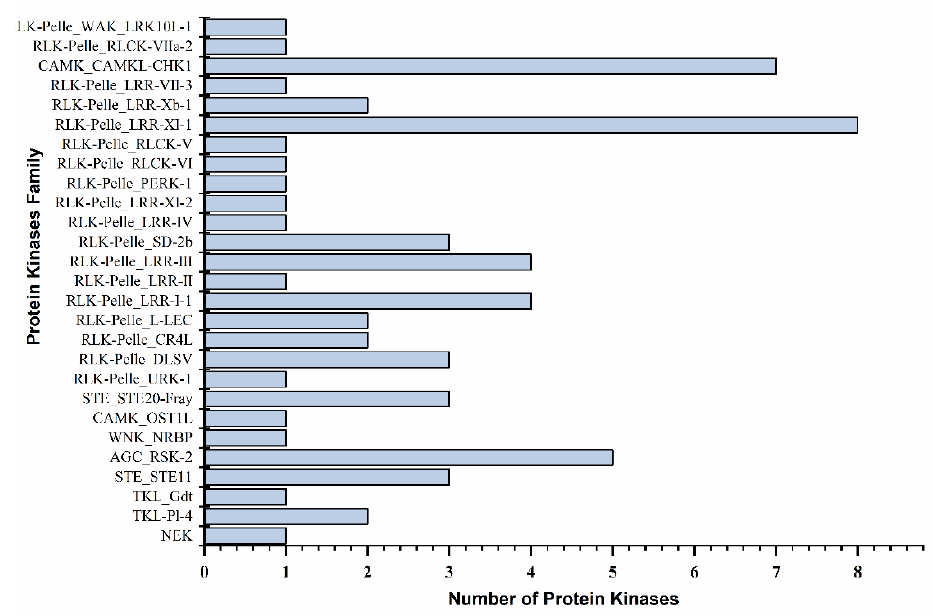
Figure 6. Differentially expressed protein kinases family against drought stress.